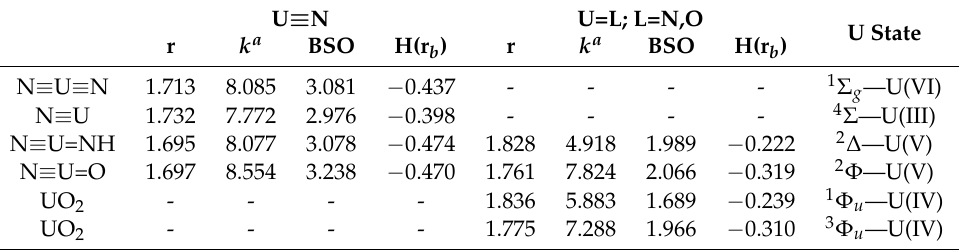
Table 1. Bond lengths in Å, k a in mDyn/Å, BSO and H( r b ), in Hartree/Å 3 , spin multiplicity